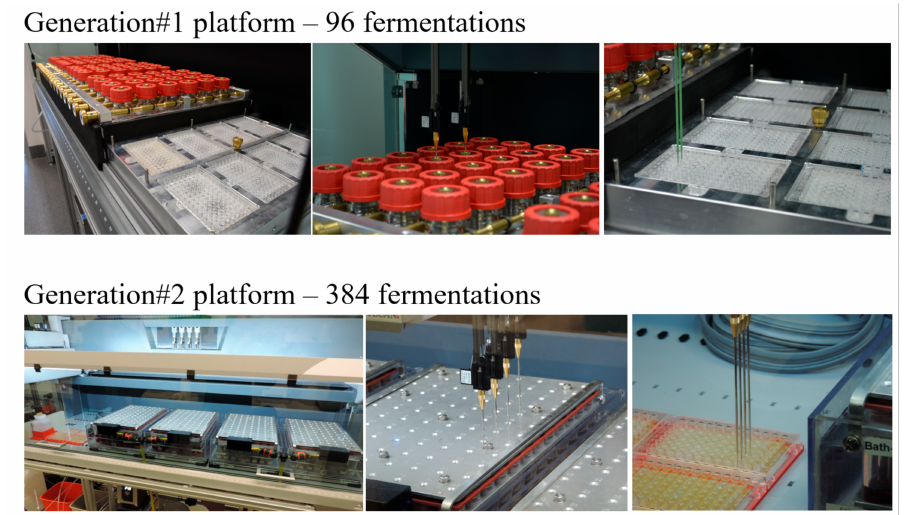
Figure 7. Generation#1 and #2 ‘Teebot’ fermentation and sampling